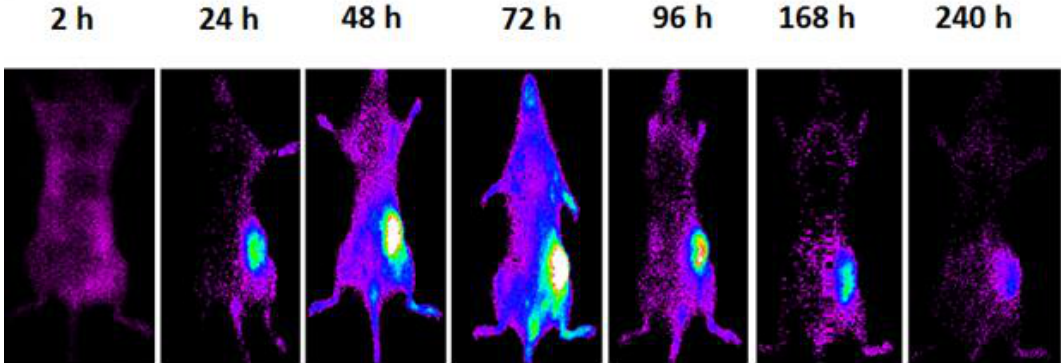
Figure 4. Whole body optical images of the same mouse bearing a subcutaneous syngeneic tumor at 2, 24, 48, 72, 96, 168, 240 h post-injection of 500 µg of fluorescent PLGA-NPs subcutaneously in the right flank.